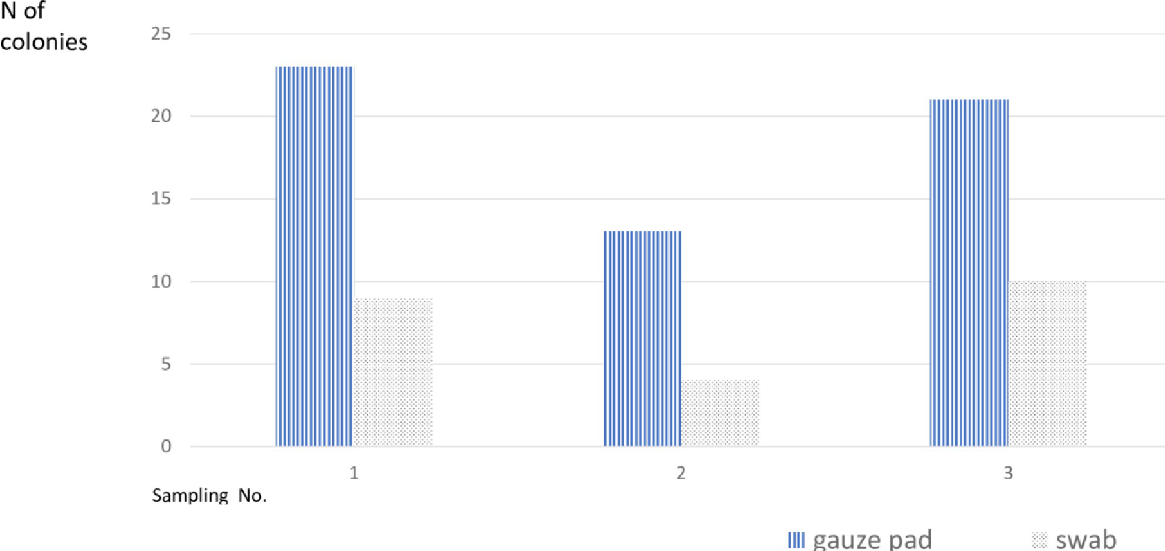
Fig 2. Number of colonies isolated in environmental cultures obtained by swab moistened with 0.9% Nacl (dotted bars) vs. gauze pad moistened with Mueller-Hinton broth (vertical stripes).